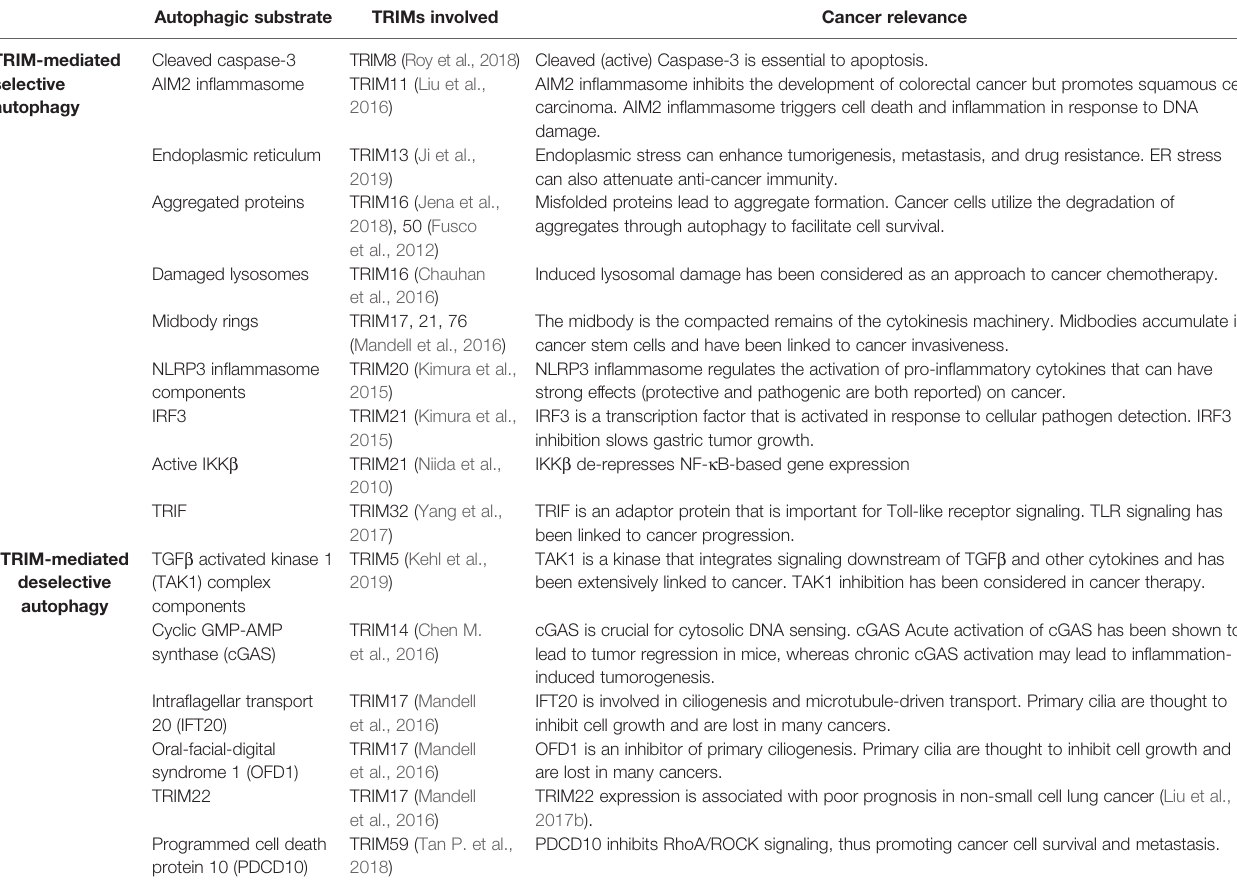
TABLE 2 | Substrates whose autophagic degradation is controlled by TRIMs. Top, in some cases, TRIMs promote the selective autophagic degradation of the listed substrates. In other cases (bottom), TRIMs ‘ deselect ’ potential autophagic substrates allowing them to accumulate in cells. Autophagic